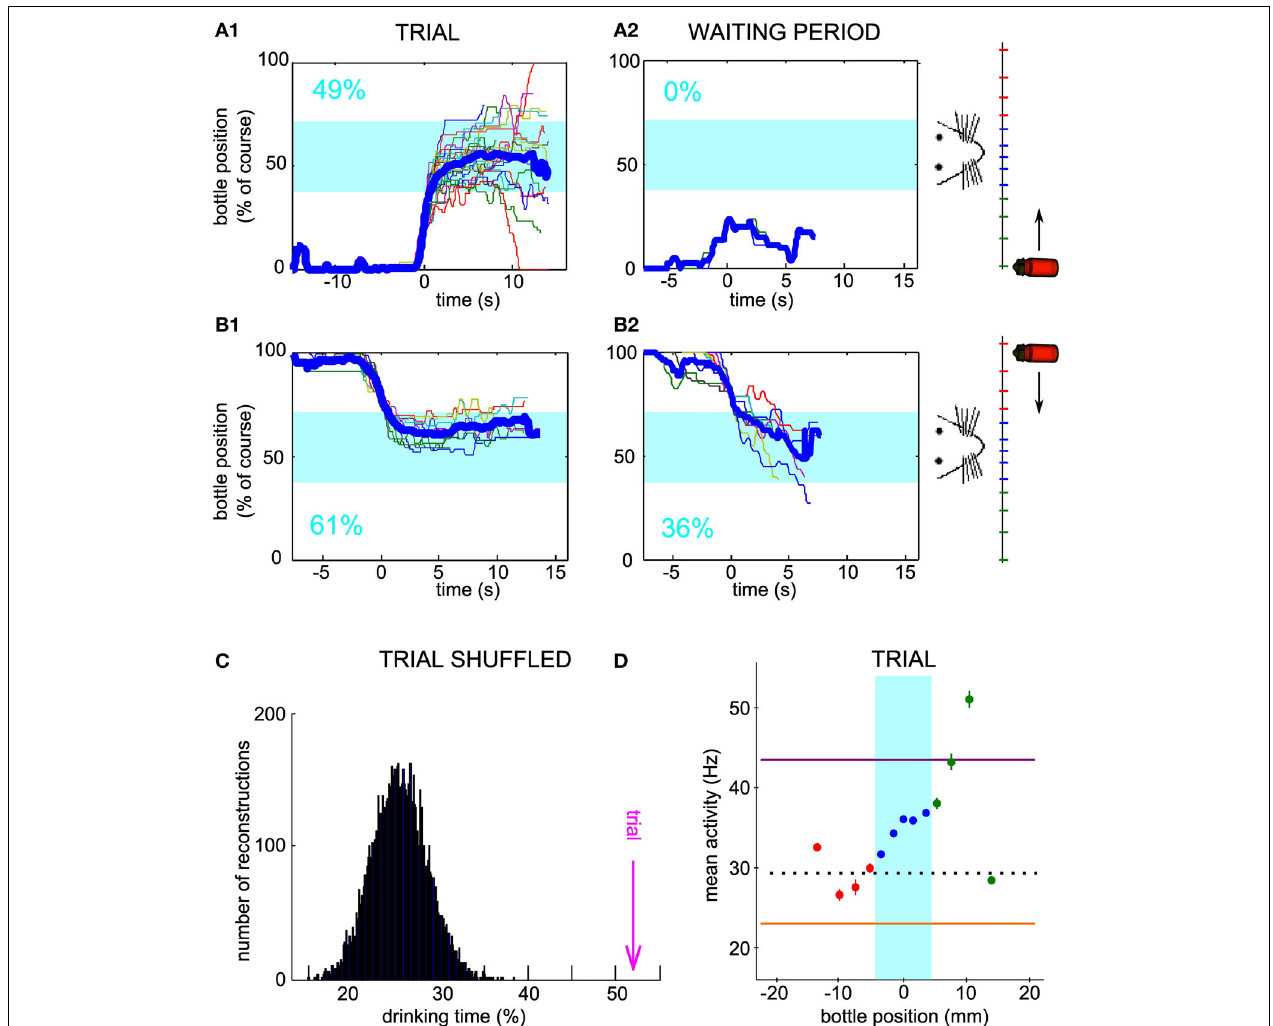
FIGURE 6 | Neuronal bidirectional control with two possible starting positions of the bottle during the same session. (A1) Superposition of all reconstructed trajectories for which the bottle started from the right and an increase in firing rate was needed at trial onset, for a conditioned neuron, different than the neurons of Figures 2 , 5 , trained with two possible starting positions during one session. The trajectories are centered in time on the position y = 20% for clarity, if the bottle reached that position (100% of the trials matched that condition). The percentage of total trial time spent in the drinking zone is displayed in the lower left corner in blue. (A2) Same as (A1) , but using the waiting period activity as an input to the neuronal control algorithm (89% of the trials matched the y = 20% condition). (B) Similar to (A) , but with trajectories for which the